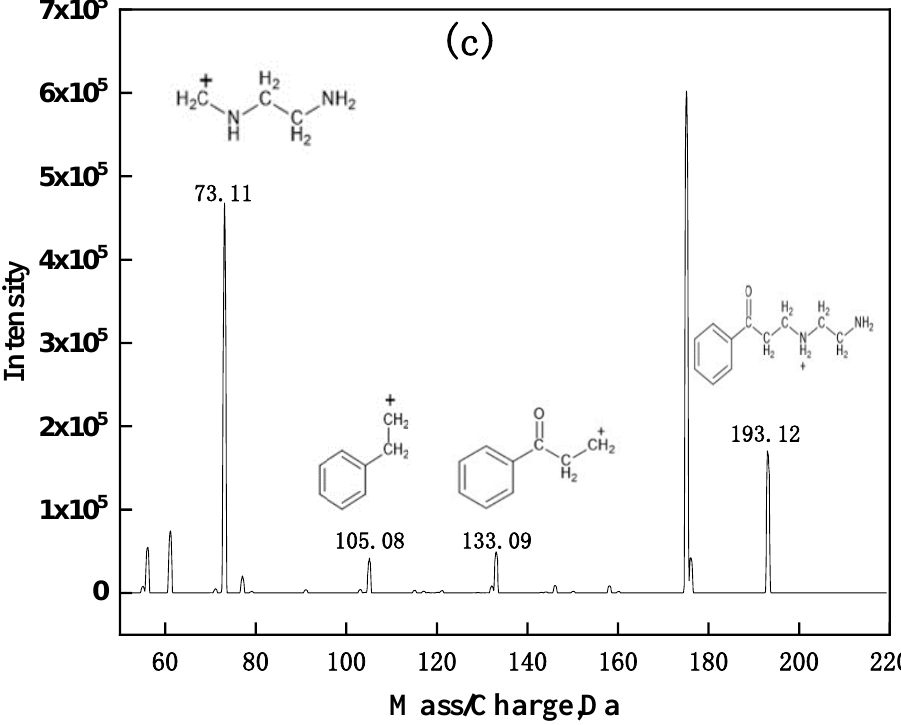
Figure 1. FTIR and LCMS of target product. ( a ) FTIR of MY1 and MY2; LCMS of MY1 ( b ) andMY2 ( c ).